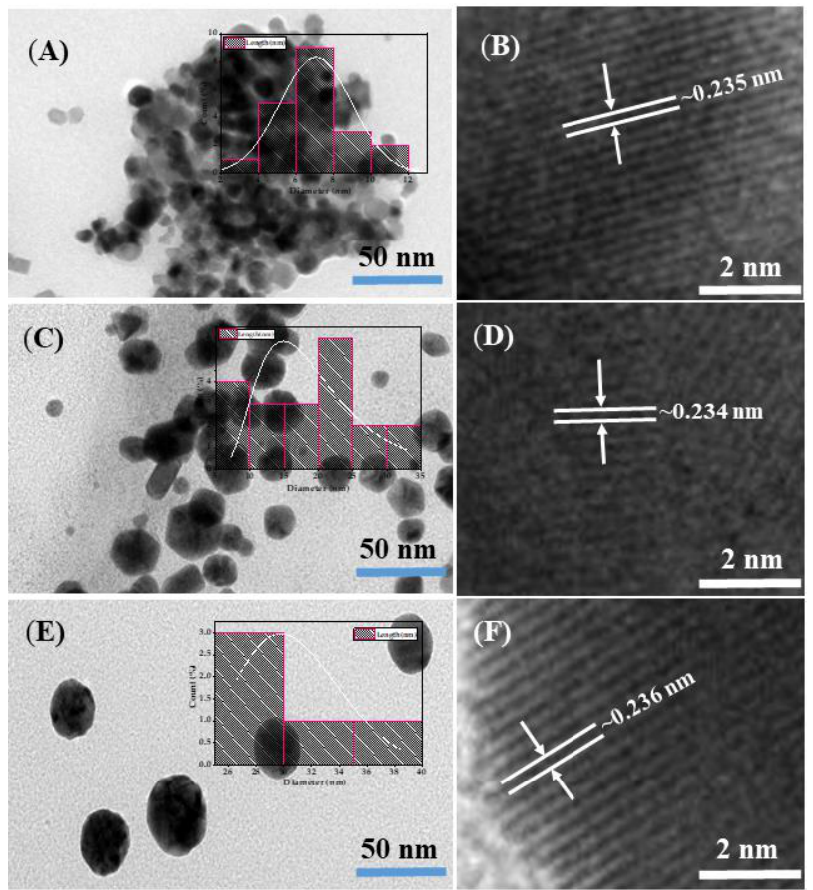
Figure 1. TEM images displaying the size of the prepared nanoparticles and HR-TEM of their corresponding images: ( A , B ) show the TEM and HR-TEM of GNPs-1; ( C , D ) illustrate the TEM and HR-TEM GNPs-2; ( E , F ) show the TEM and HR-TEM of GNPs-3. Insets of Figure 1A,C,E, show histograms of size distribution for GNPs-1, GNPs-2, and GNPs-3, respectively.